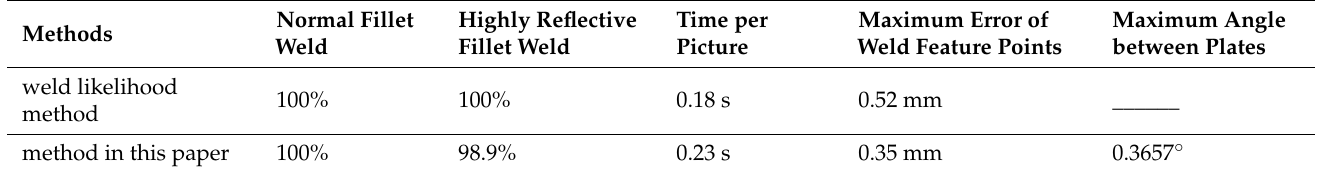
Table 4. Comparison of the test results between the weld likelihood method and the method in this